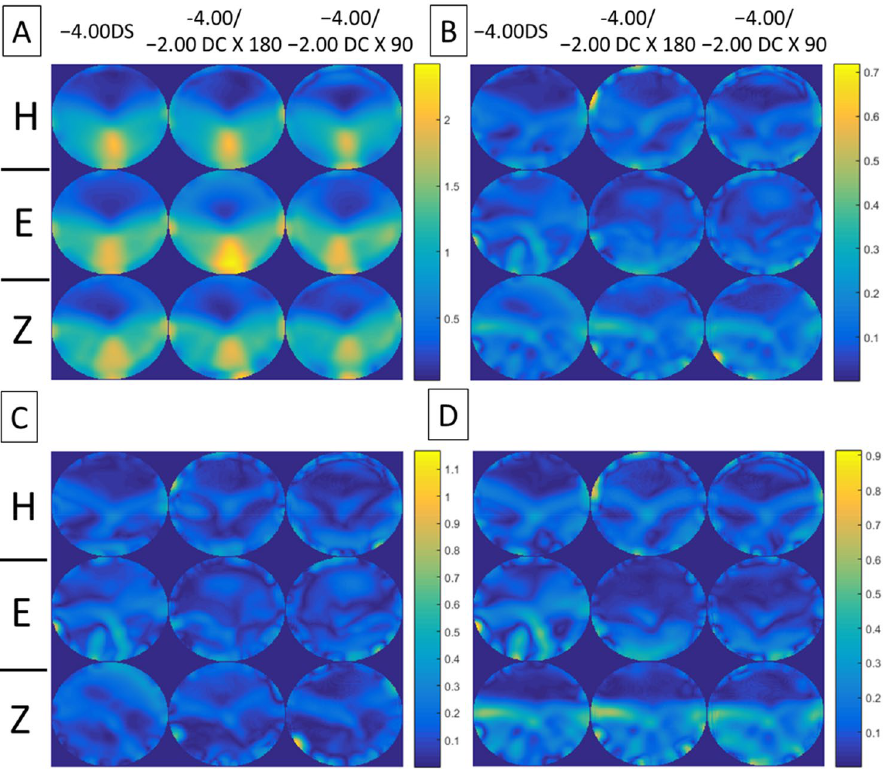
Figure 7. Error maps of overall refraction (cid:31) L . ( A ) Mean and ( B ) standard deviation of the error maps at distant viewing distance for four lenses (2 models × 2 corridor lengths) with the same prescription (columns) from the three lens manufacturers (rows: H Hoya, E Essilor, Z Zeiss). ( C ) and ( D ) show mean absolute differences of the error maps for PALs of different models and corridor lengths, respectively. Note that the scales of color-coded maps are different.